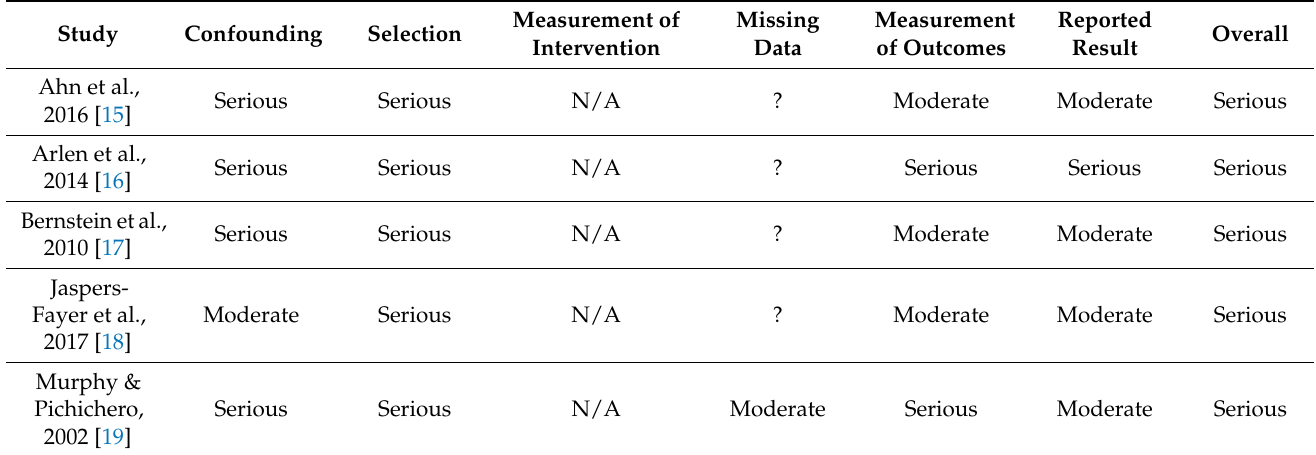
Table 2. Risk of bias assessment with ROBINS-I